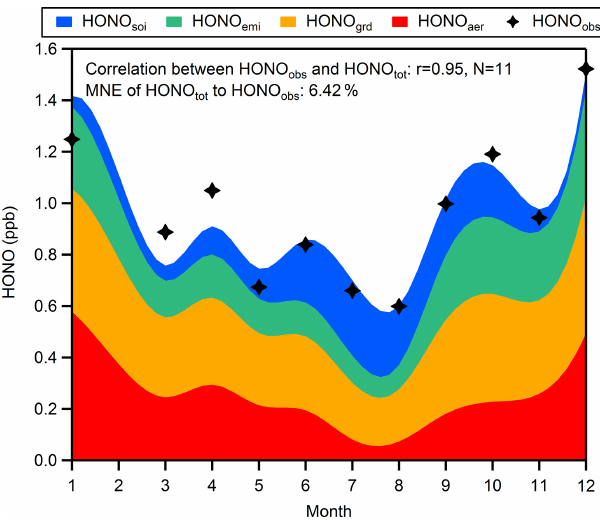
Figure 9. Seasonal variations of four sources of HONO at night (03:00–06:00LT). The mean normalized error (MNE) of HONO tot to HONO obs is